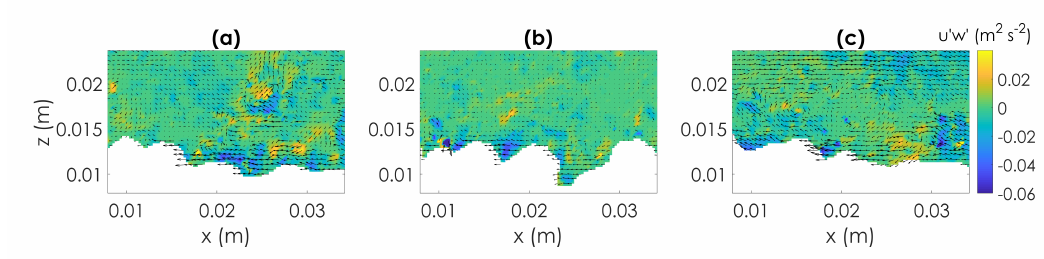
Figure 19. Instantaneous Reynolds shear stress maps with vectors superimposed representing velocity fluctuations obtained for Type D (particle 4, Test T2) for the sequence of three PIV images reported in Figure 18. (For clarity only 1 out of 2 vectors are depicted.) ( a ) Initial instantaneous Reynolds stresses. A ejection event is observed close to the particle at rest. ( b ) Induced instantaneous Reynolds stresses by passing particles. ( c ) Several particles are mobilized and corresponding instantaneous Reynolds